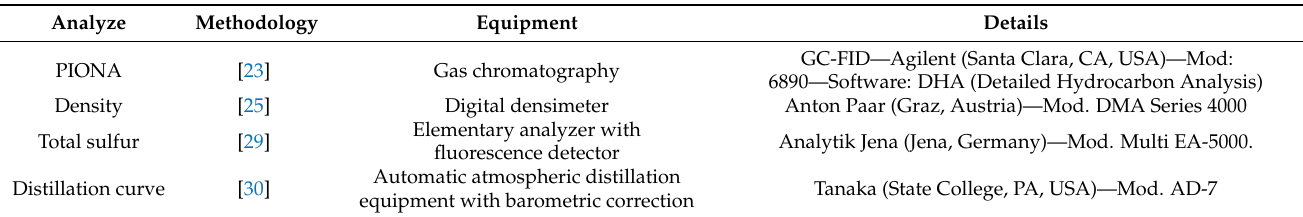
Table 5. Analyses performed for naphtha